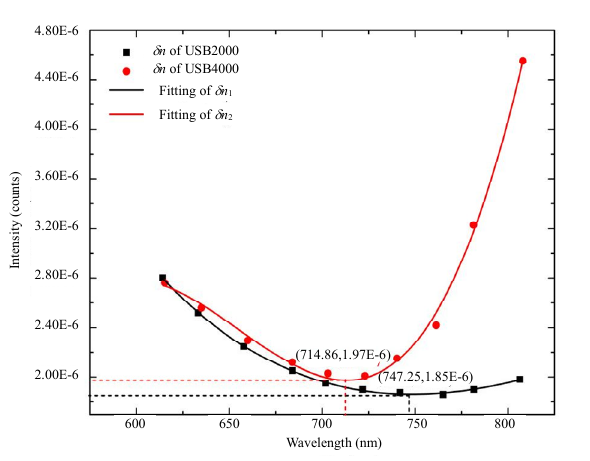
Fig. 14 RI resolution curves corresponding to USB2000 spectrometer and USB4000